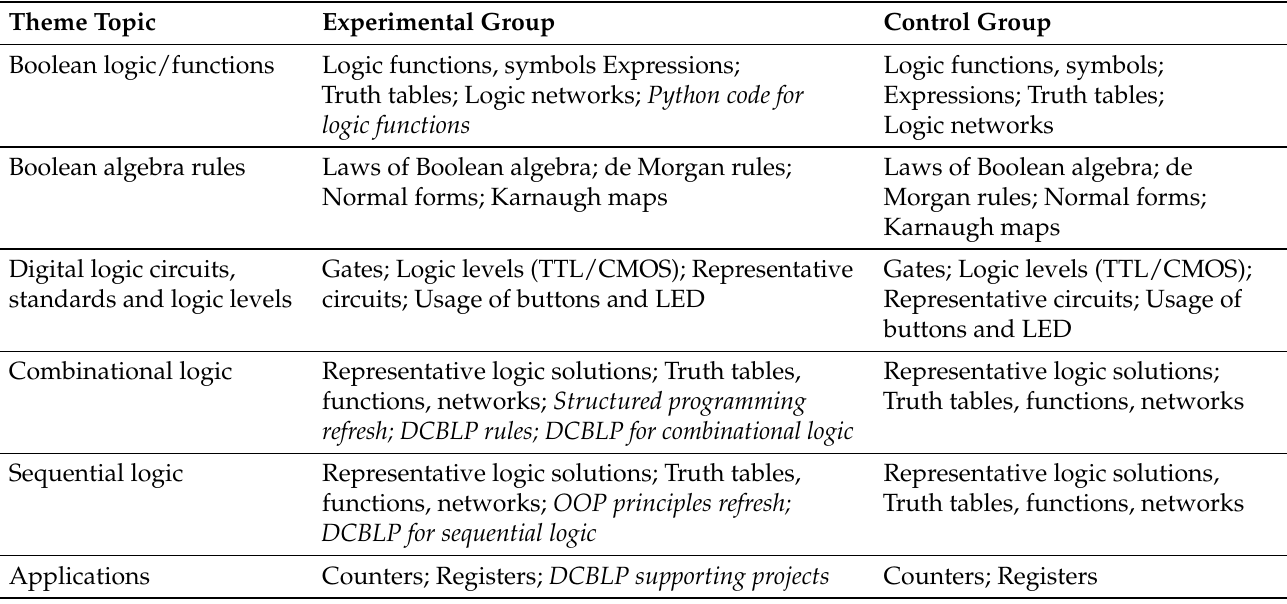
Table 3. Training content in experimental and control